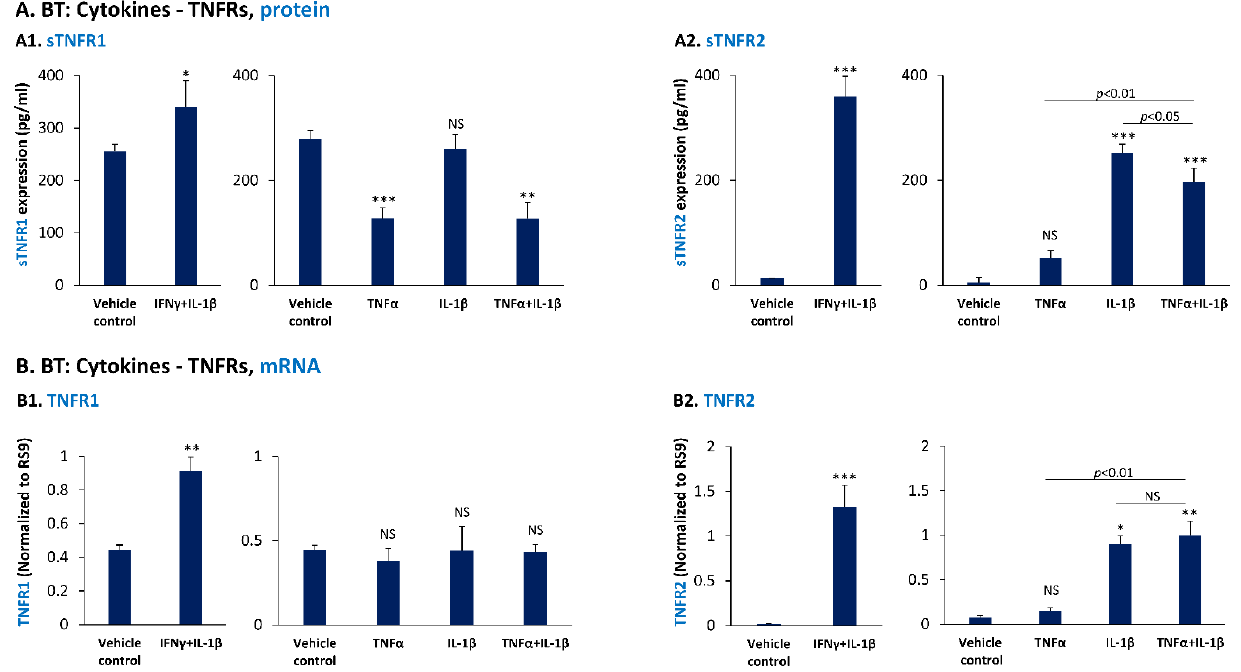
Figure 8. Pro ‐ inflammatory cytokines up ‐ regulate the expression of cell ‐ derived sTNFR2 by BT ‐ 549 cells, but have a divergent effect on cell ‐ derived sTNFR1 expression levels. ( A ) BT ‐ 549 cells (BT) were stimulated by IFN + IL ‐ 1 β (concentrations as in Figure 2), by TNF α and/or IL ‐ 1 β (concentrations as in Figure 1) or treated by a vehicle control for 48 h. sTNFR1 ( A1 ) and sTNFR2 ( A2 ) levels were determined in CM of the cells by ELISA. In each panel, a representative experiment of n = 3 is presented. *** p < 0.001, ** p < 0.01, * p < 0.05. NS, not significant. ( B ) BT cells were stimulated by IFN γ + IL-1 β (concentrations as in Figure 2), TNF α and/or IL ‐ 1 β (concentrations as in Figure 1) or treated by a vehicle control for 5 h. TNFR1 mRNA ( B1 ) and TNFR2 mRNA ( B2 ) levels were determined by qPCR. In Panel ( B1 ), the data of TNF α and/or IL ‐ 1 β stimulation demonstrate the average ± SD of n = 4 experiments, due to high variability between the assays. In all other figures of Panel ( B ), a representative experiment of n = 3 is presented. *** p < 0.001, ** p < 0.01, * p < 0.05. NS, not significant. Statistical analyses were performed as described in Section 2.